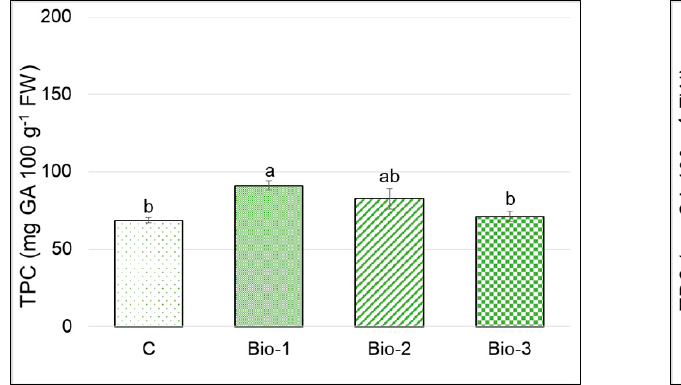
Figure 4. Effect of biostimulants (Bio-1 = TRAINER ® ; Bio-2 = AQUAMIN, and Bio-3 = Moringa oleifera leaf extract) on nitrates content (mg kg − 1 ) in turnip greens ( a ) and radish ( b ) microgreens. Data are means ± se ( n = 3). Different letters indicate significance at p ≤ 0.05 according to the LSD test.